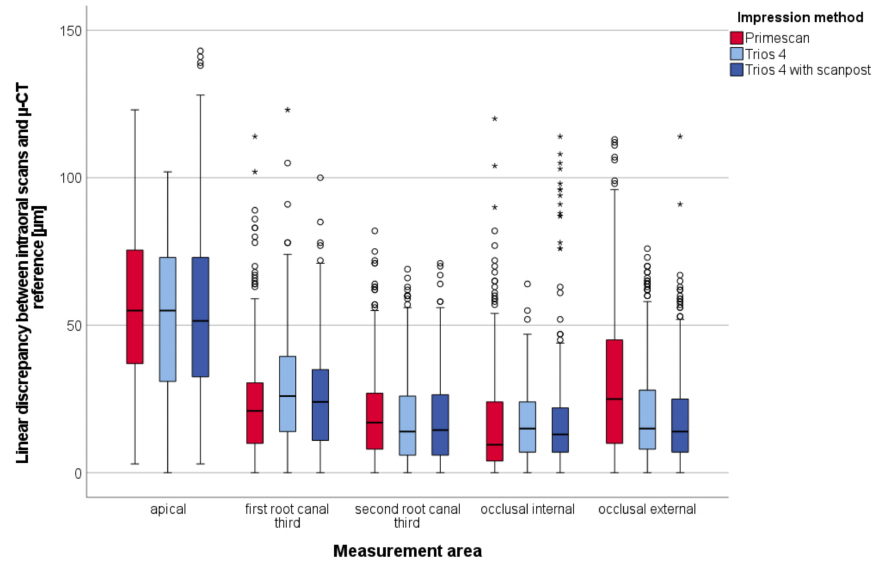
Figure 7. Boxplot diagram of the linear discrepancy ( µ m) between intraoral scans of all three impression methods and reference µ -CT distributed to the five measurement areas; outliners (O), extreme values